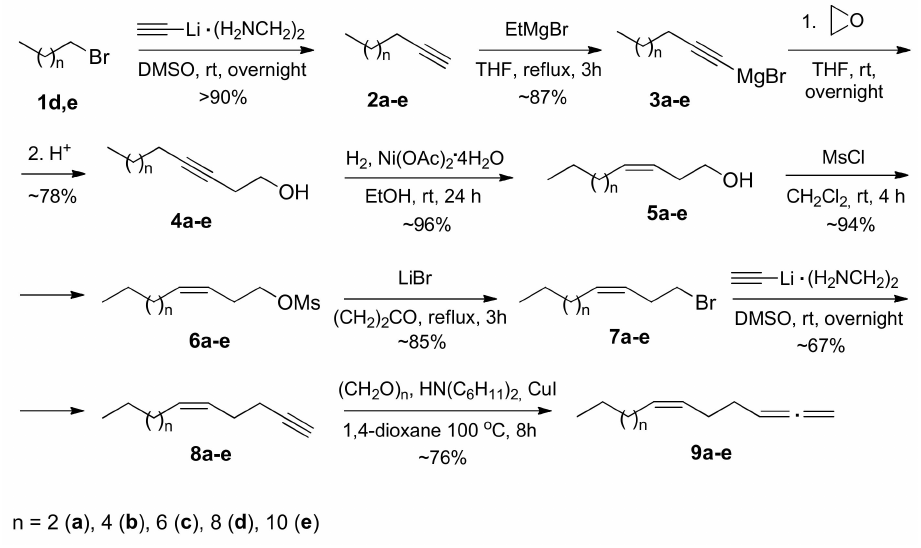
Scheme 2. Synthesis of (6 Z )-alka-1,2,6-trienes ( 9a – e ). According to the synthetic route to 1 Z ,5 Z ,9 Z -trienoic acids (5 Z ,9 Z ,13 Z -octadecatrienoic